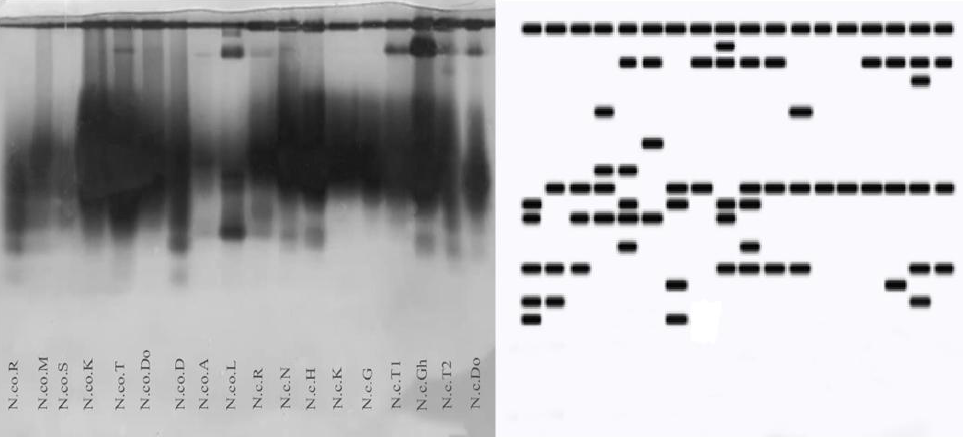
Fig. 6. Electrophoretic patterns of peroxidase isoenzyme bands in different populations of N. complanata and N. crispa